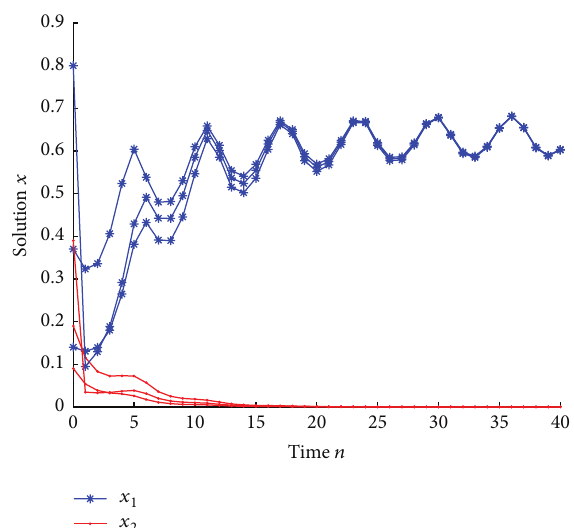
Figure 2: Dynamic behaviors of system (95) with initial values (0), 𝑥 (0)) = (0.14, 0.19) , (0.27, 0.69) , and (0.8, 0.39) , respec- (𝑥 1 2